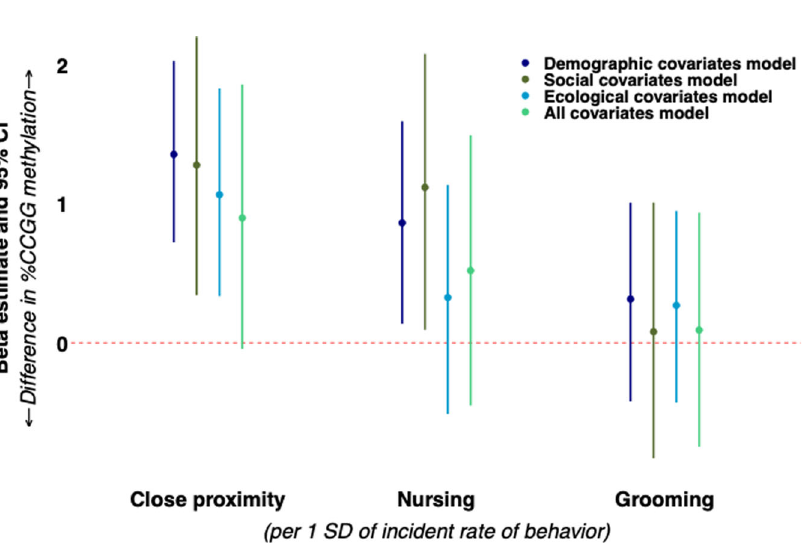
Fig. 1 Associations of maternal care behaviors with cub and subadult offspring %CCGG methylation among N = 55 hyenas. All models included a random intercept for maternal ID to account for relatedness and the offspring ’ s age in months at the time of blood sample collection for DNA methylation quanti fi cation. Models were further adjusted according to four types of covariates (demographic covariates [dark blue], early social experience covariates [dark green], ecological covariates [light blue], and a fully adjusted all covariates model [light green]). 95% CIs were based on percentile bootstrapping (2000 iterations). Source data are provided as a Source Data fi Next, we assessed relationships between social network metrics derived during the hyenas ’ CD and DI periods of development and %CCGG methylation. During the CD period, strength (0.75 were each positively associated with %CCGG methylation in demographic covariates models (Fig. 2). These relationships were attenuated after adjusting for early social experience and ecological covariates. Network degree was not associated with % CCGG methylation in any of our models during the CD period and none of the interaction terms involving social network metrics and maternal social rank were signi fi cant. During the DI period, network degree was positively associated with %CCGG. Each 1-SD increment in degree corresponded with 0.69 (95% CI: 0.03, 1.38) higher %CCGG methylation in the demographic covariates model. This association was strengthened